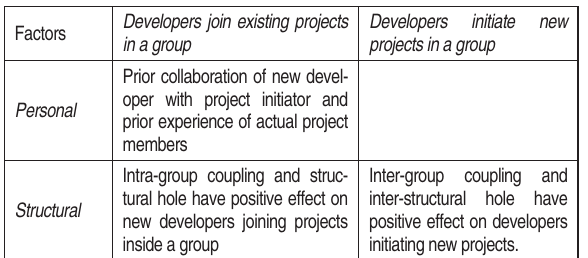
Table 1. Factors influencing developers to join projects or initiate new